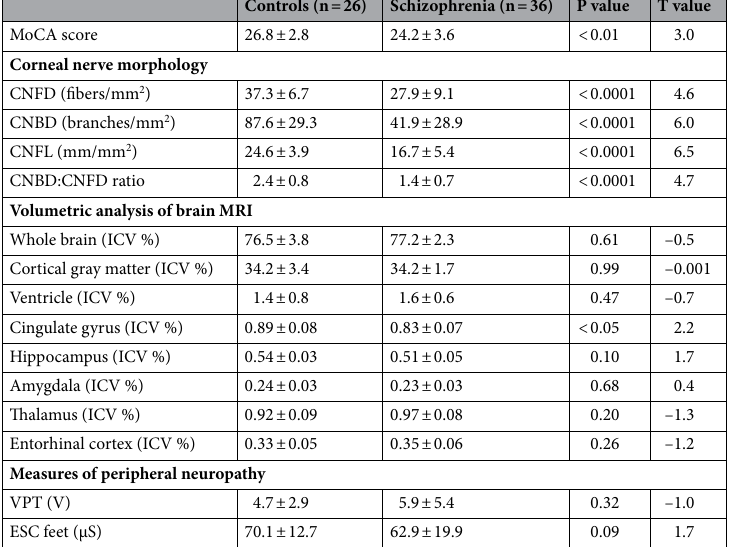
Table 1. Comparison of cognitive function, corneal nerve morphology, volumetric brain MRI and measures of peripheral neuropathy between subjects with schizophrenia and controls. Numeric variables and frequency distribution for categorical variables are summarized as mean ± standard deviation or n (%). Variables were compared using unpaired t-test. Categorical variables were compared using x 2 . MoCA montreal cognitive